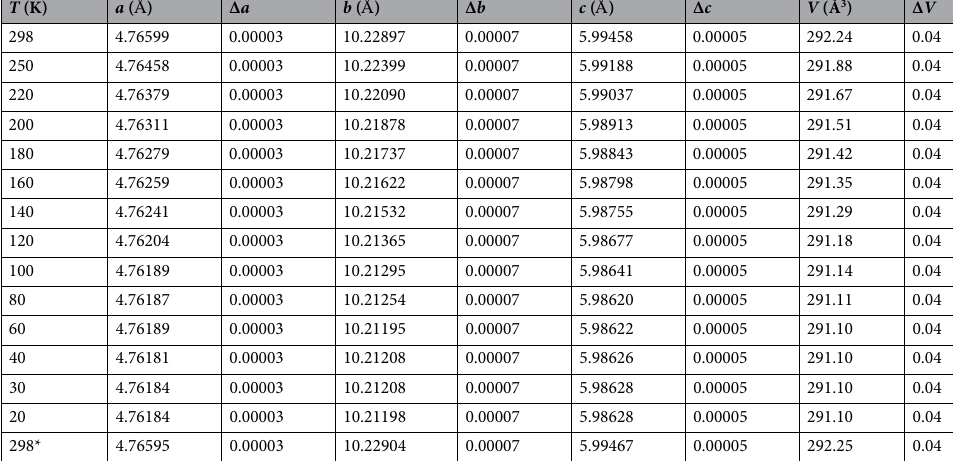
Table 1. Unit-cell parameters as a function of temperature. Unit-cell parameters and volumes of olivine studied in this work with composition Mg 1.84 Fe 0.16 SiO 4 at different temperatures between 20 and 298 K. Data are scaled to 298 K unit-cell parameters of Table 4 for the high-T dataset 7 as the differences in unit-cell parameters were negligible. Raw low-T data are available for Mg 1.84 Fe 0.16 SiO 4 olivine, which contains NIST silicon as internal standard. *Measured after cooling to verify the perfect reversible behavior before and after the cooling to 20